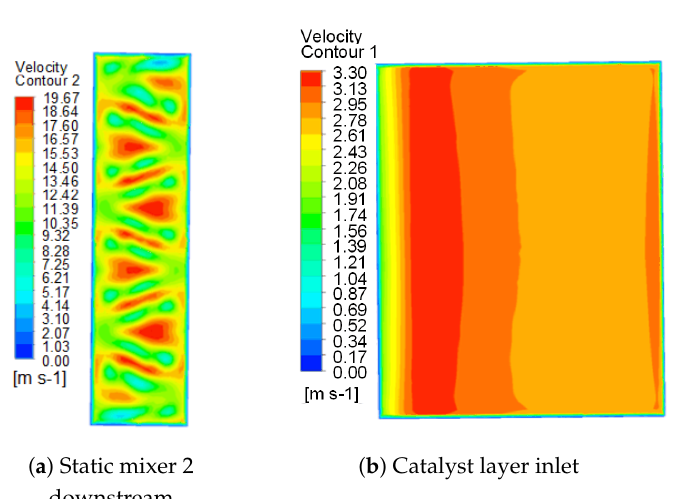
Figure 10. Velocity field with static mixer 2. ( a ): Velocity distribution diagram of downstream of static mixer. ( b ): Velocity distribution diagram of section in front of the catalyst layer.